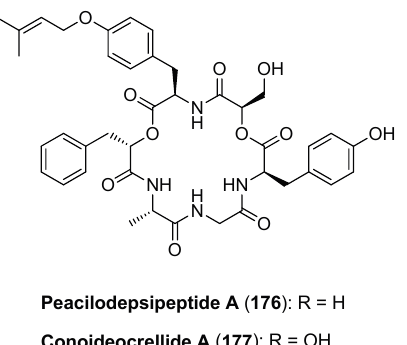
Figure 18. Structure of paecilodepsipeptide A and conoideocrellide A.